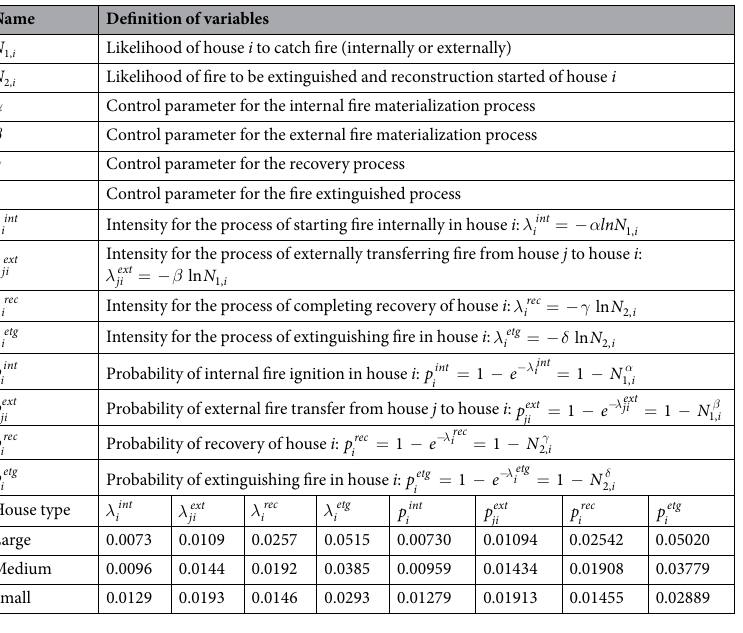
Table 2. Definition of variables, intensities of Poisson processes, and the probabilities of the corresponding Bernoulli processes for the parameter values: ( N 1, i ; N 2, i ) = (0.4; 0.2) for large, (0.3; 0.3) for medium, and (0.2; 0.4) for small houses. α = 0.08, β = 0.012, γ = 0.016 and δ = 0.032.